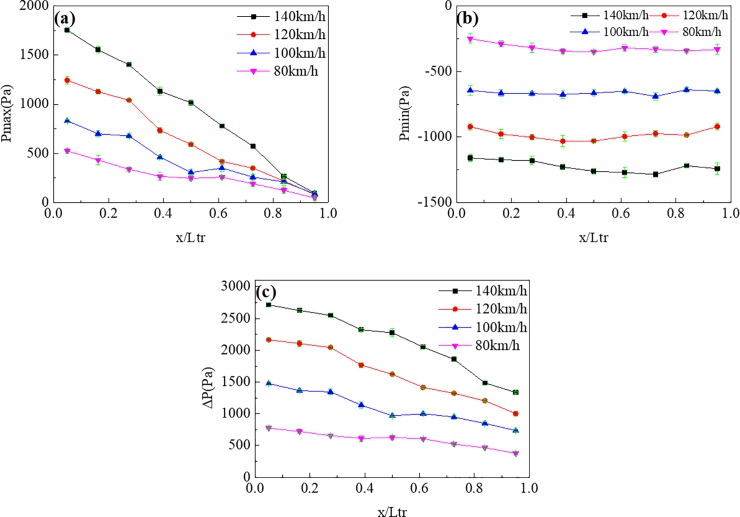
Pressure values at different points (z/H = 0.49) on the train surface under different speeds.(a), (b), and (c) show Pmax, Pmin, and ΔP, respectively.